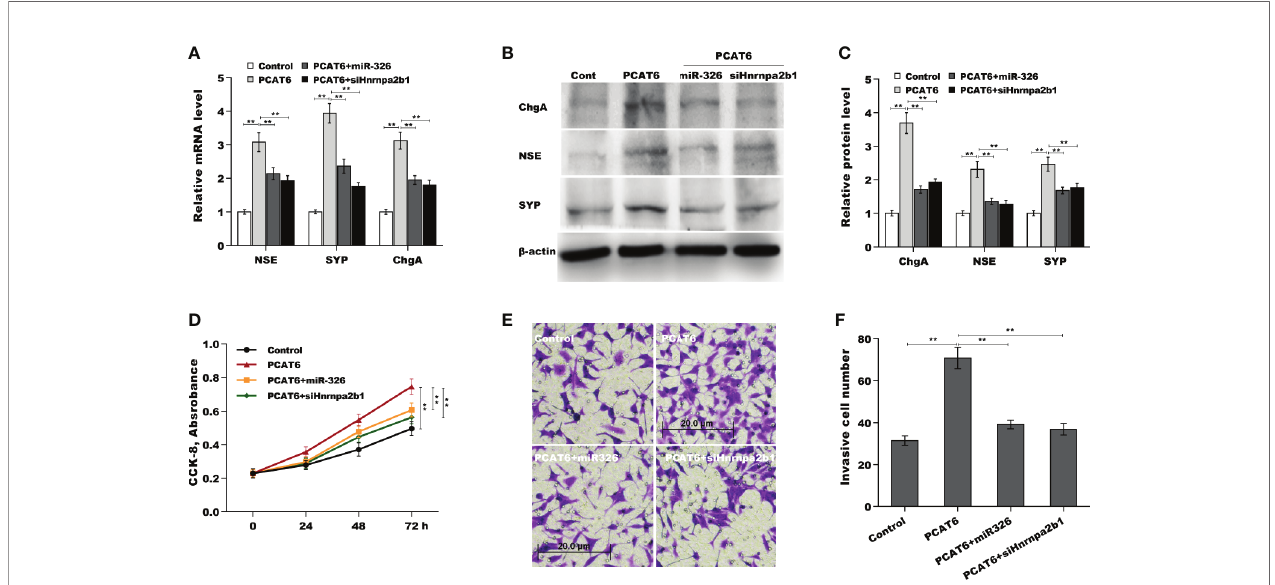
FIGURE 6 | The role of PCAT6/miR-326/Hnrnpa2b1 axis in regulating PCa cells proliferation, invasion, and NED. (A) qPCR analysis of NSE, SYP, and ChgA mRNA expression in LNCaP cells after PCAT6 overexpression in the presence or absence of miR-326 overexpression or Hnrnpa2b1 knockdown. (B, C) Western blot analysis for NSE, SYP, and ChgA protein level in LNCaP cells after PCAT6 overexpression in the presence or absence of miR-326 overexpression or Hnrnpa2b1 knockdown. (D) LNCaP cell proliferation was assayed using CCK-8 after PCAT6 overexpression in the presence or absence of miR-326 overexpression or Hnrnpa2b1 knockdown. (E, F) LNCaP cell invasion was assessed using transwell invasion assay after PCAT6 overexpression in the presence or absence of miR-326 overexpression or Hnrnpa2b1 knockdown. ** p